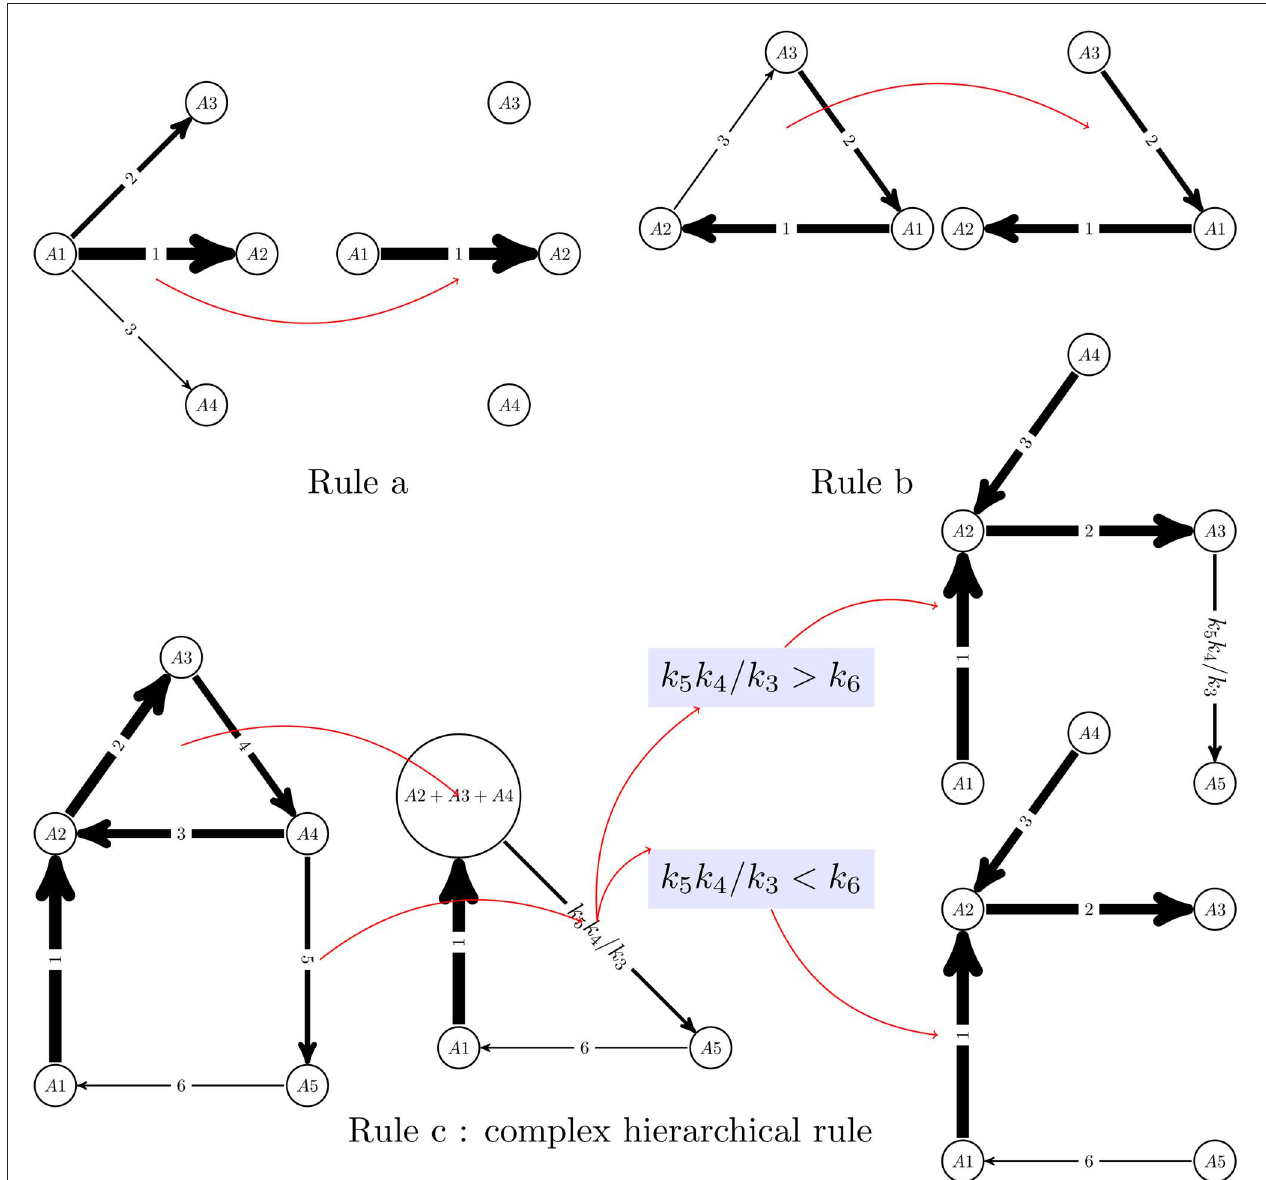
FIGURE 1 | Reduction algorithm for linear networks. A monomolecular network with total separation can be represented as a digraph with integer labels (the quickest reaction has label 1). Two simple rules allow to eliminate competition between reactions (rule a) and transform cycles into chains (rule b). Rule b can not be applied to cycles with outgoing slow reactions, in which case more complex, hierarchical rules should be applied (rule c). In the rule